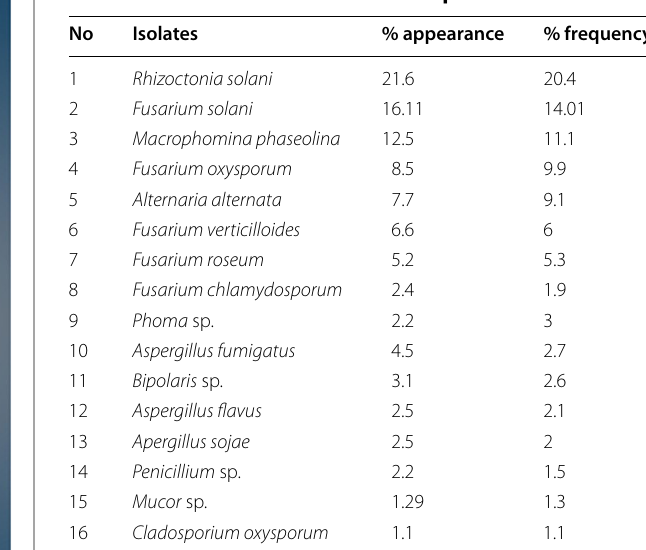
Table 3 Percentage of frequency and appearance of fungi